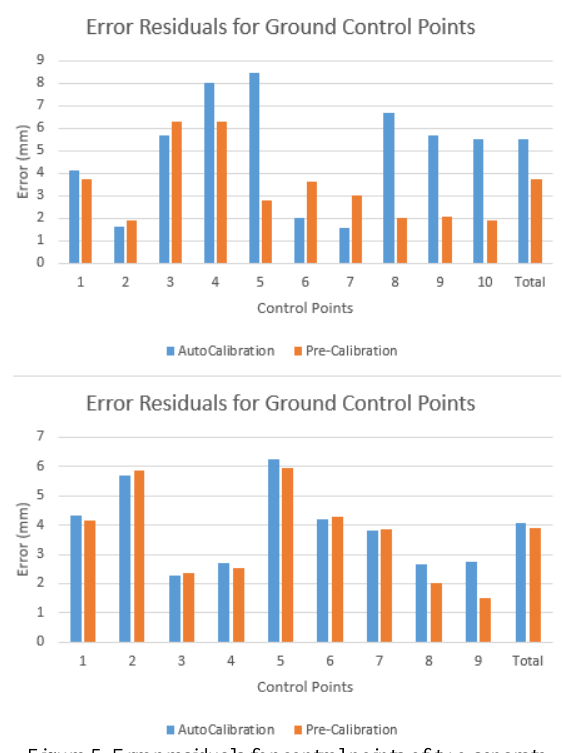
Figure 5. Error residuals for control points of two separate missions flown over the same scene on different days; July 13, 2018 (top), July 16, 2018